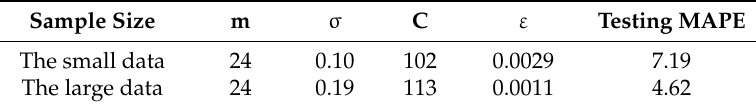
Table 4. The SVR’s parameters for data-I in Case